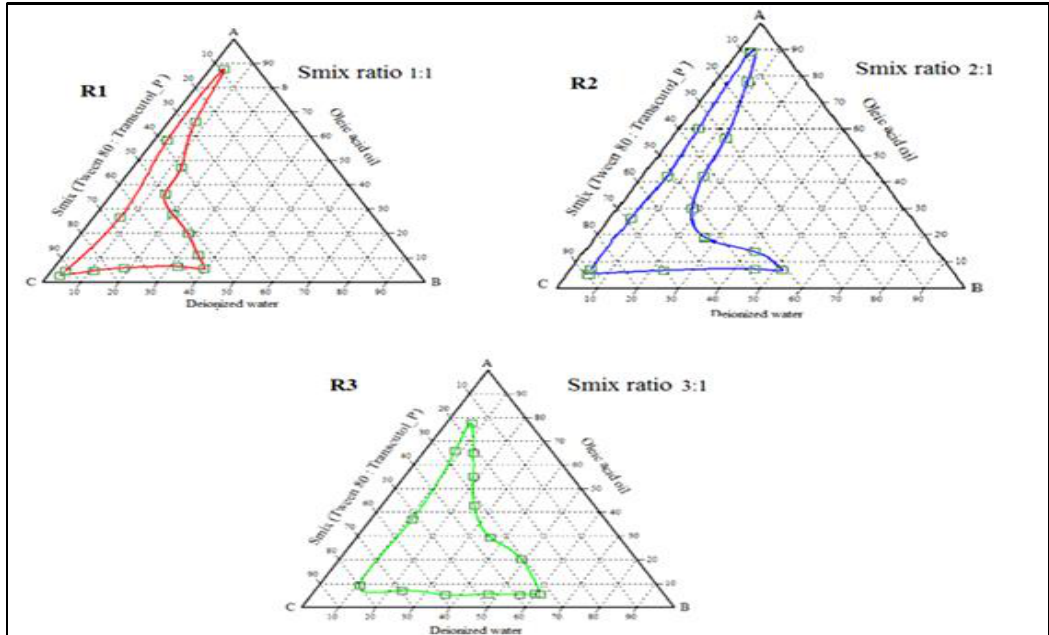
Figure 1. Pseudo-ternary phase diagrams of the quaternary containing oleic acid / tween 80/ transcutol p ® / water as oil/surfactant/co-surfactant/aqueous phase, respectively at different Smix ratios; R1: Smix (1:1), R2: Smix (2:1), R3: Smix